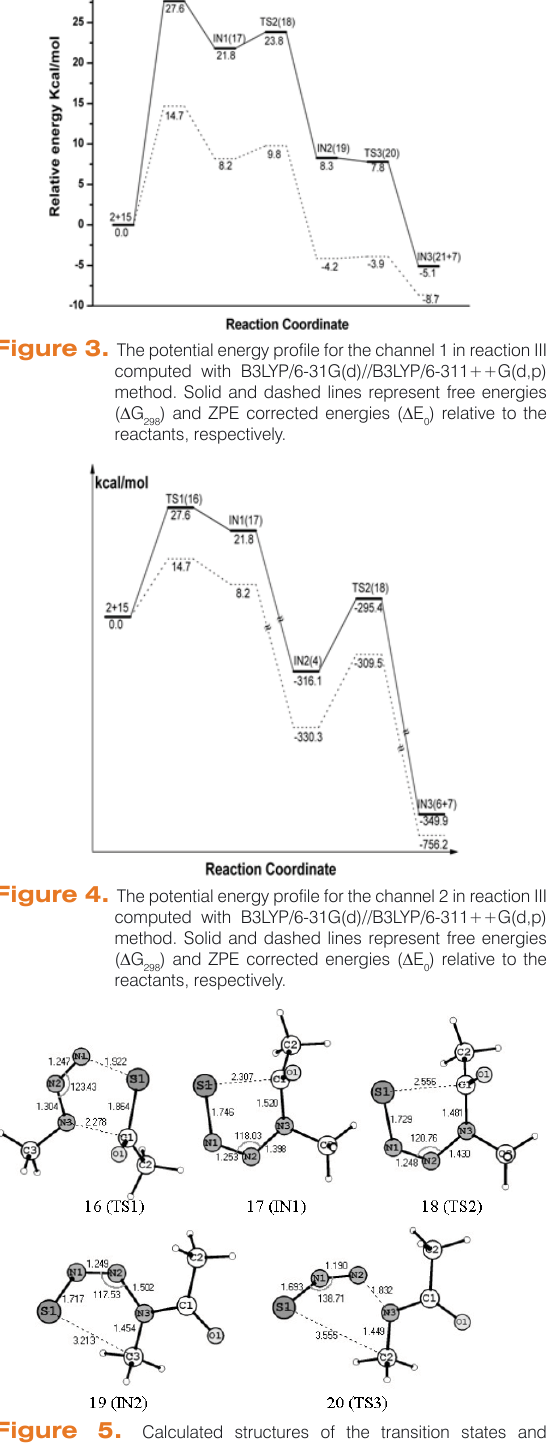
Figure 5. Calculated structures of the transition states and intermediates for the channel 1 in reaction